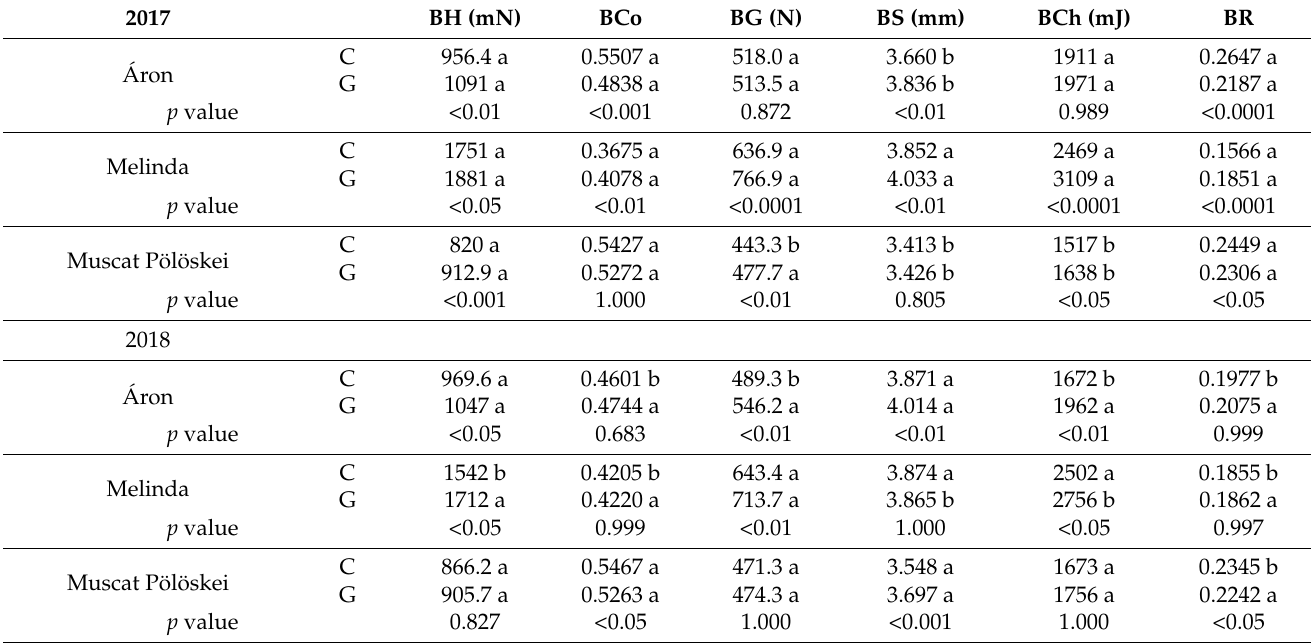
Table 2. Results of the grape berry texture profile analyses in 2017 and 2018.